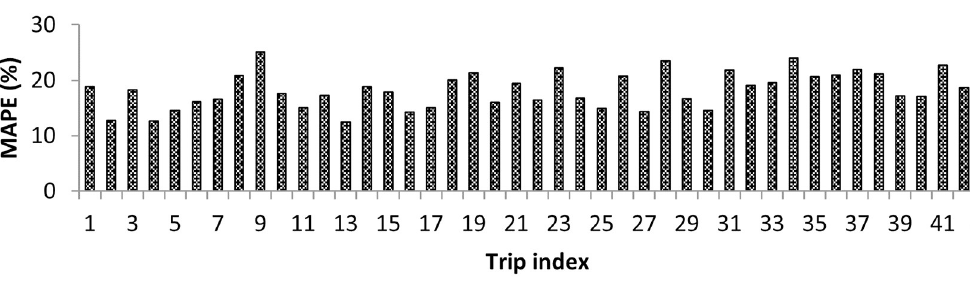
Fig 10. MAPE for all trips on a sample day.